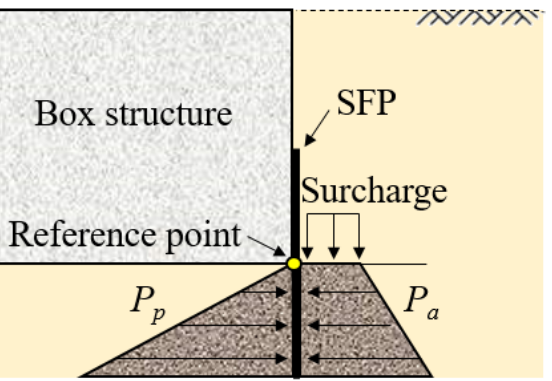
Figure 13. Types of earth pressure acting on the SFP. P p : passive pressure; P a : active pressure [26].